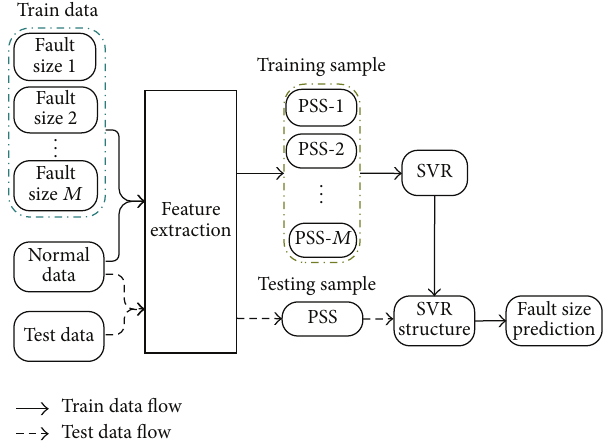
Figure 3: Framework of the fault size prediction.